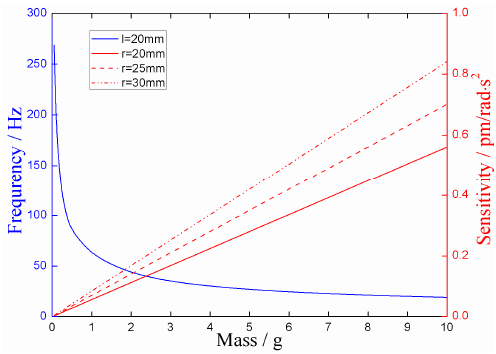
Figure 5. The curves of the sensor’s frequency and sensitivity change with mass of the mass ball.